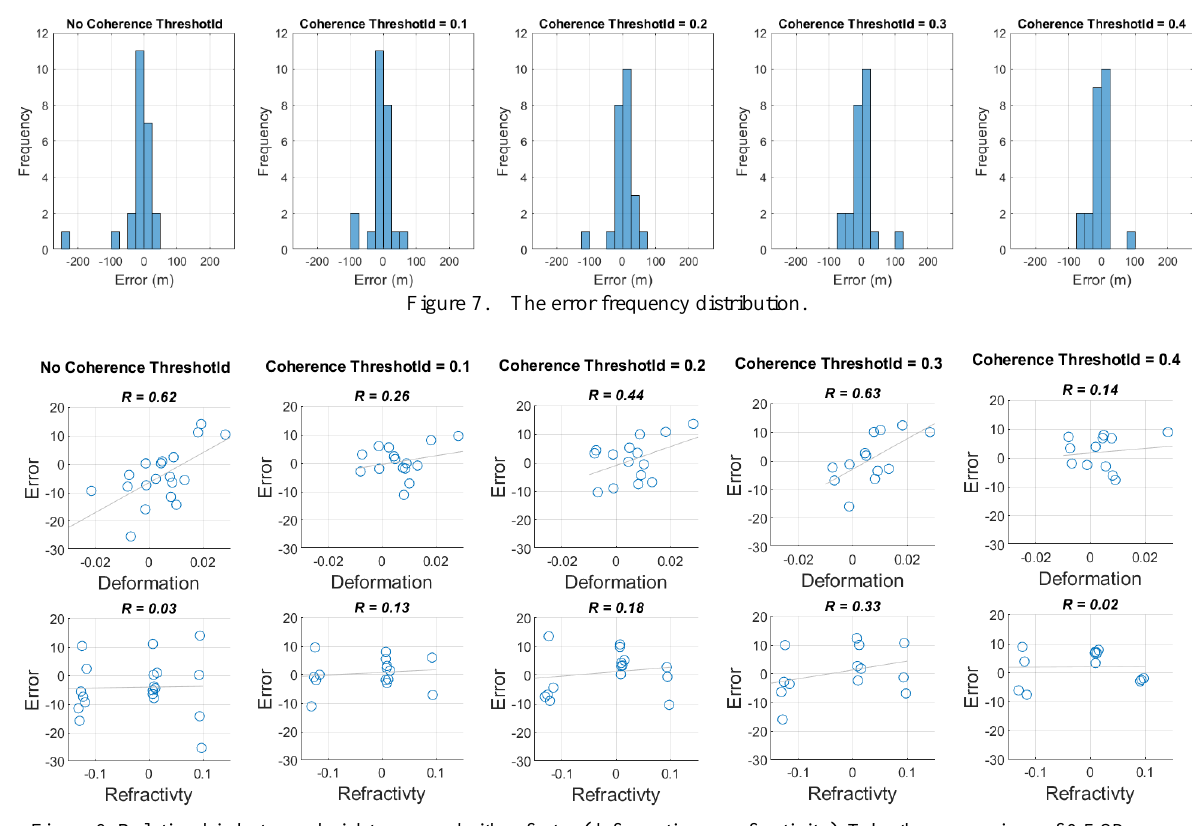
Figure 9. Relationship between height error and either factor (deformation or refractivity). Take the comparison of 0.5 SD as